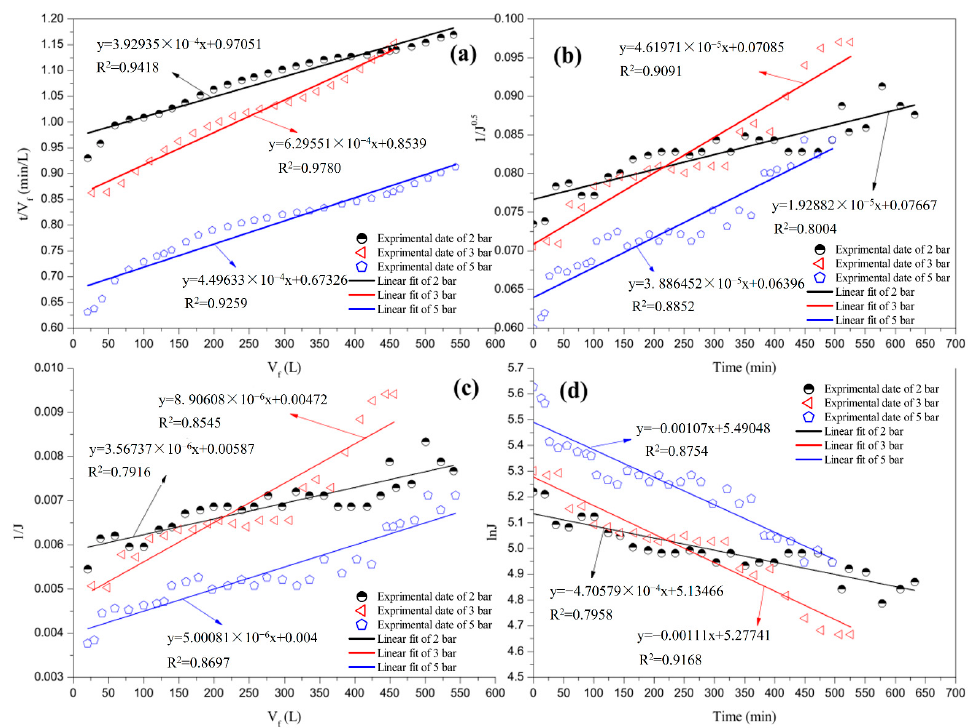
Figure 6. Linear fit with four fouling models at various TMPs: ( a ) cake filtration; ( b ) pore narrowing; ( c ) combination of external and progressive internal fouling; and ( d ) complete pore blocking. Table 6. R 2 values of regression by different TMPs for four fouling models.